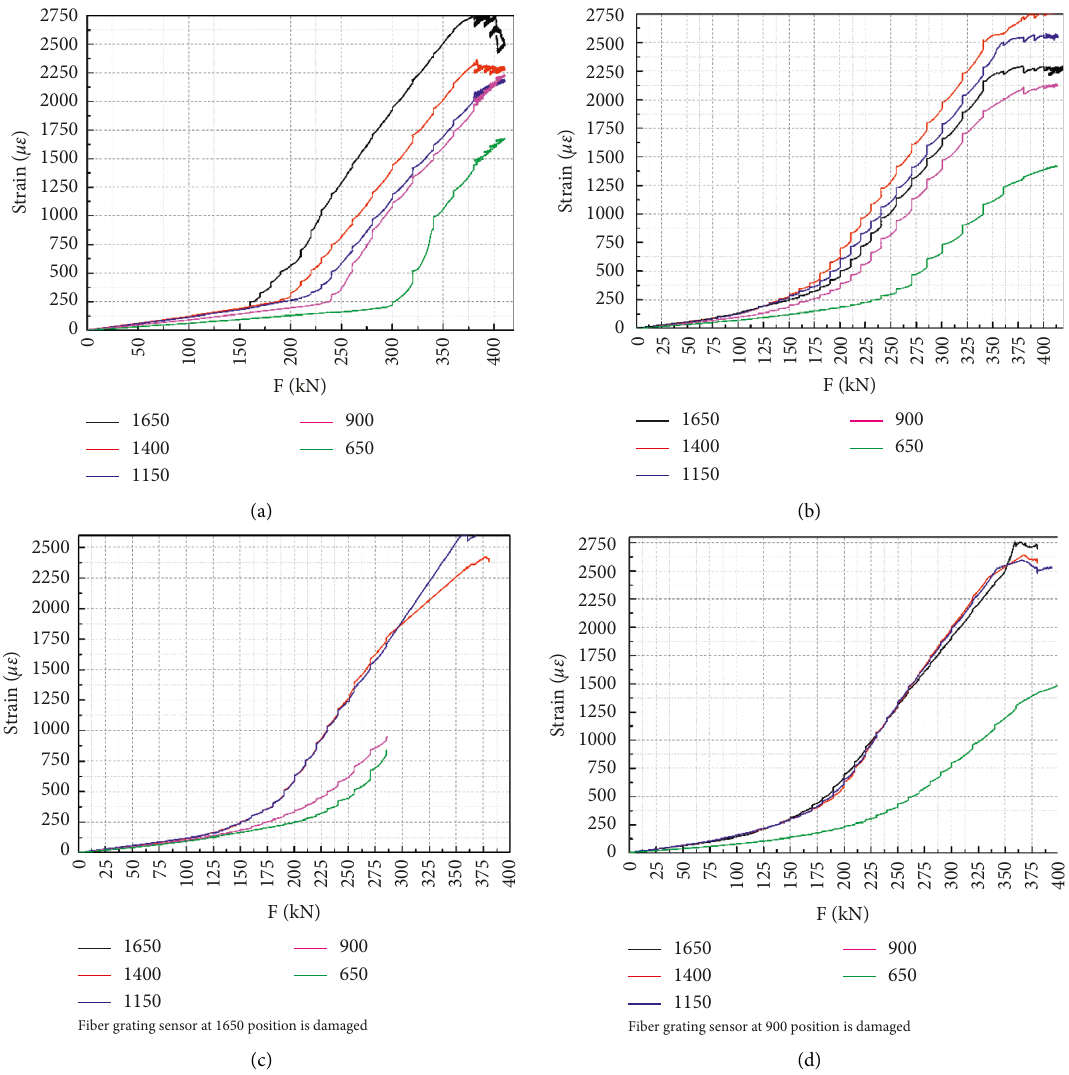
Figure 14: Load-strain curves of longitudinal reinforcement (figures in legend are the distance between measuring point and beam end, mm). (a) 0P10, (b) 10P10, (c) 10H10, and (d)